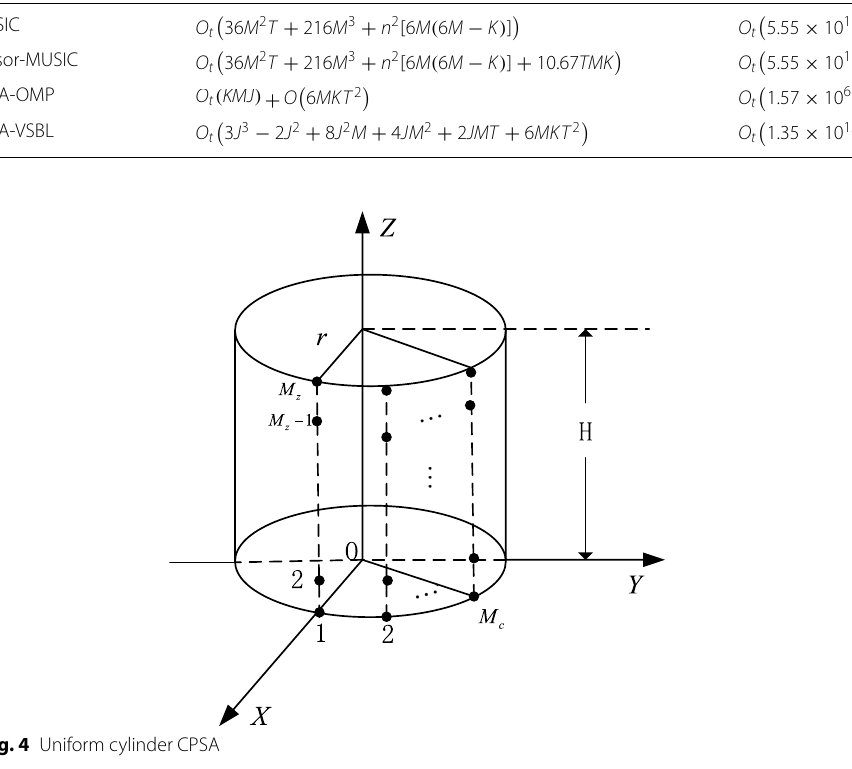
Table 3 Comparison of computational load